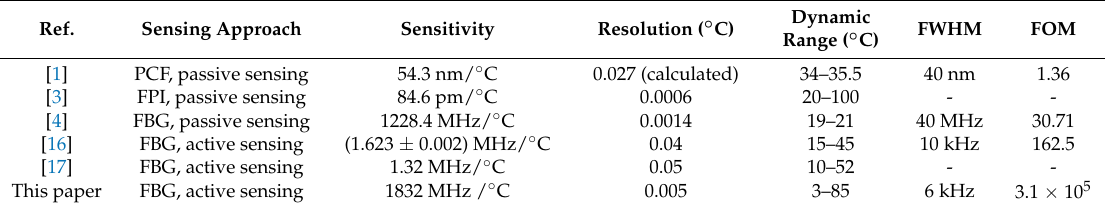
Table 1. Performance comparisons of the proposed sensor with sensors referred to prior.